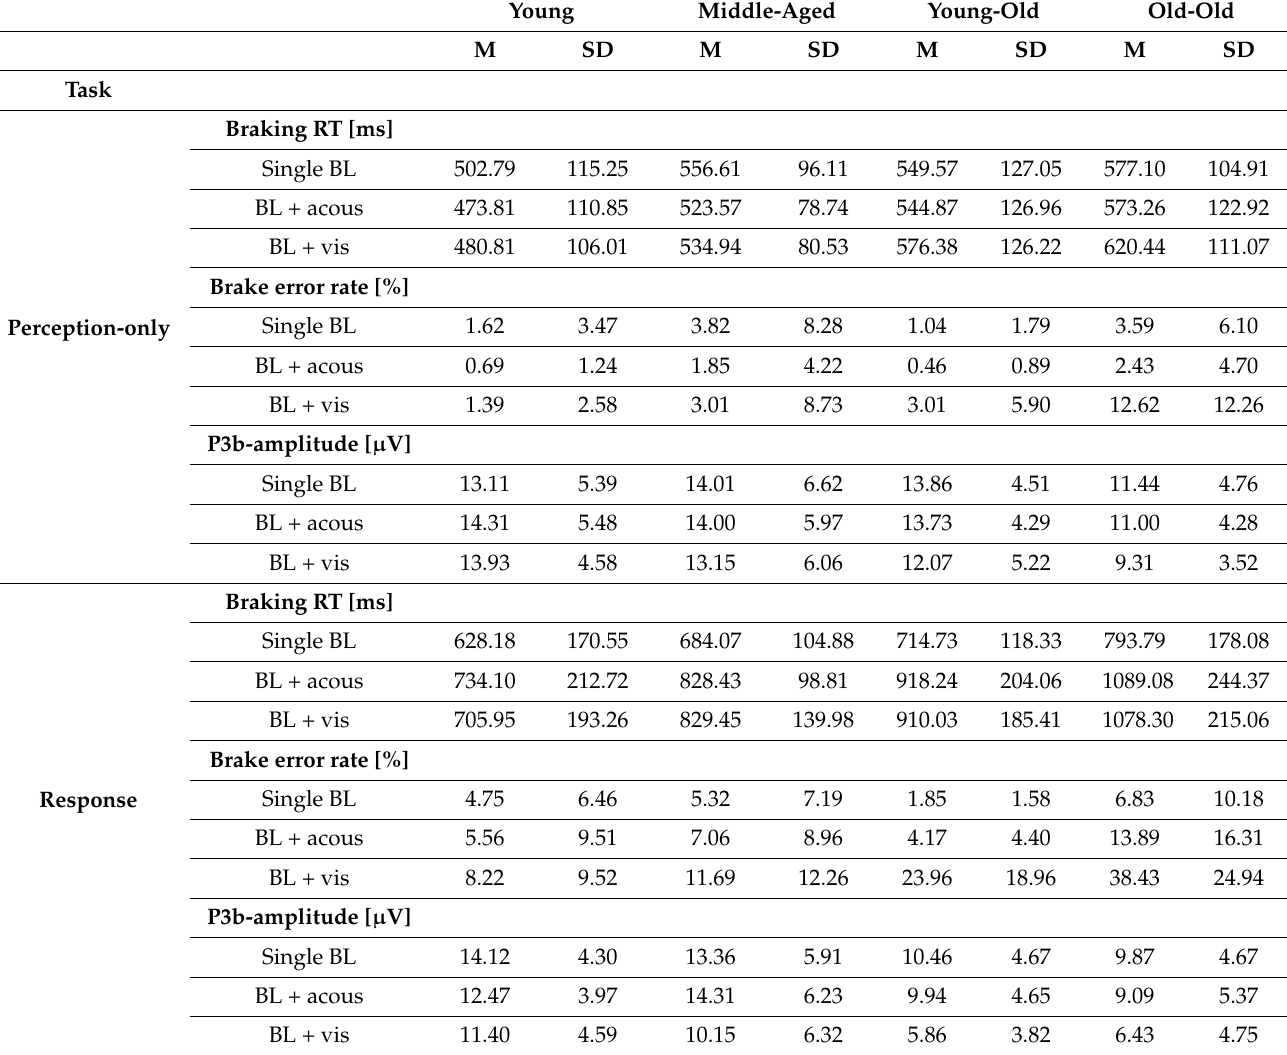
Table 1. Means (M) and standard deviations (SD) of braking RTs, error rates, and P3b-amplitudes of the four age groups in the perception-only, response and inhibition task, presented separately for single brake lights (Single BL), brake lights with additional acoustic stimuli (BL + acous), and brake lights with additional visual stimuli (BL + vis). Young Middle-Aged Young-Old Old-Old M SD Task